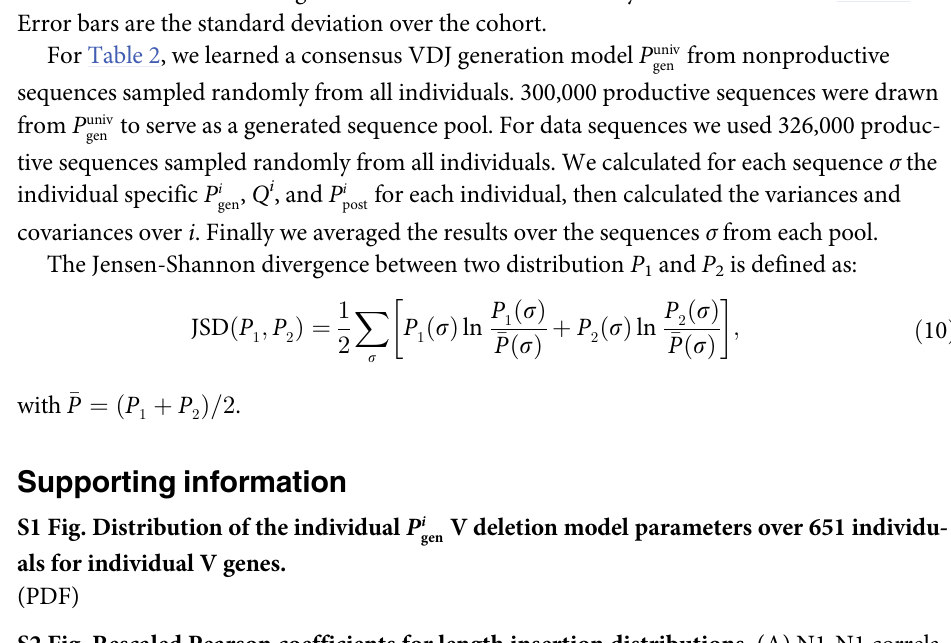
S2 Fig. Rescaled Pearson coefficients for length insertion distributions. (A) N1-N1